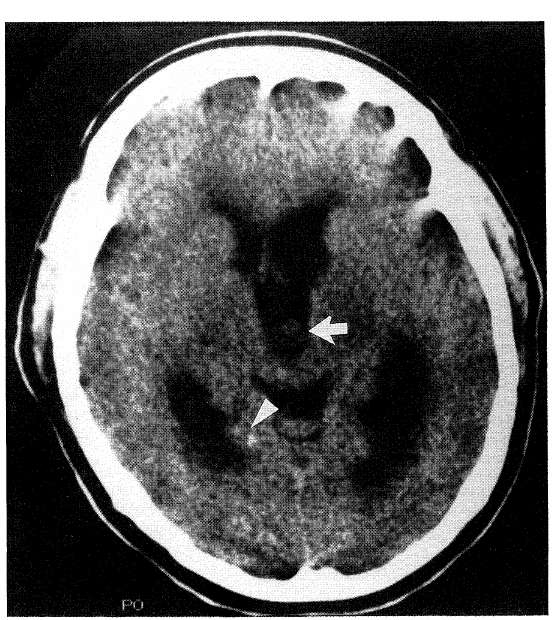
Fig. I. Axial CT scan on admission. There is hydroceph- alus, manifested by dilation of the third and lateral ventricles, with periventricular calcifications (arrowhead). The intra- ventricular cysticercus cyst (arrow) is seen as a soft-tissue density within the dilated third